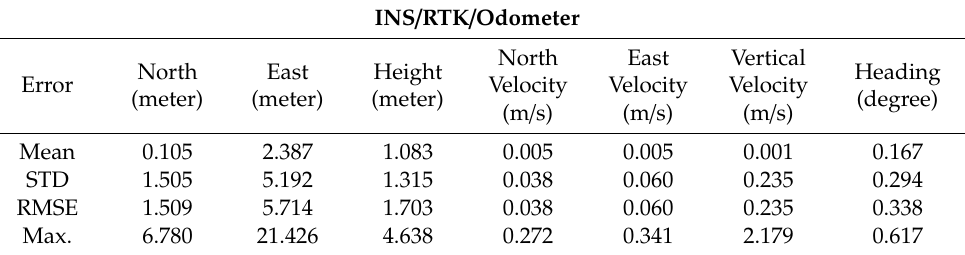
Table 4. Statistical analysis of INS / RTK / odometer.